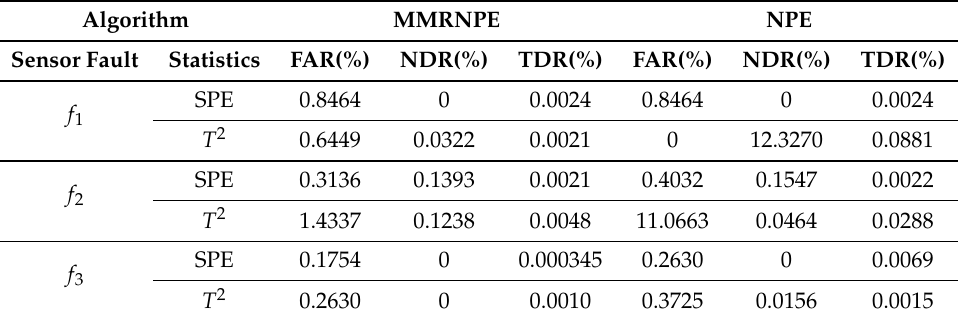
Table 3. The detection indexes of various sensor faults with MMRNPE and NPE.